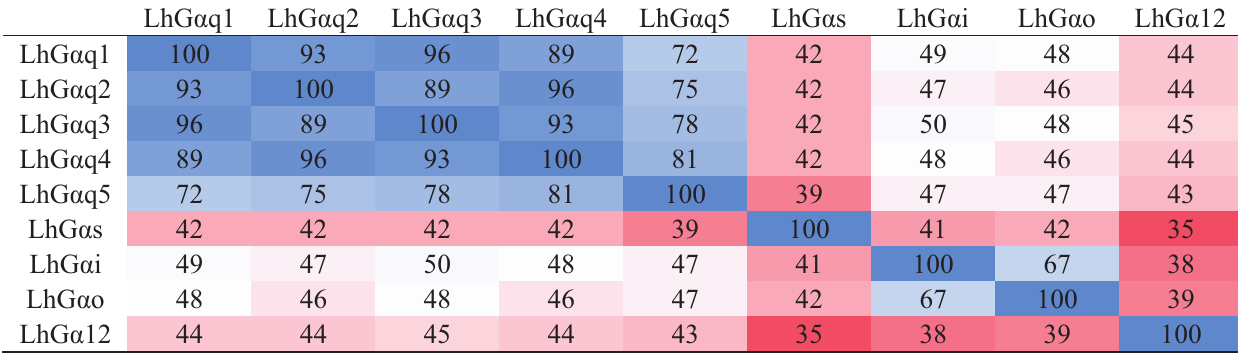
Figure 2. Alternative splice variants of LhG(cid:2)q. ( A ) MUSCLE-based sequence alignment of LhG(cid:2)q1-4; ( B ) MUSCLE-based sequence alignment of LhG(cid:2)q5 with LhG(cid:2)q1 and G(cid:2)q variants from A. gambiae (AAW50316; AgG(cid:2)q5) and Diaphorina citri (XP_008479779; DcG(cid:2)q1). The alignment corresponds to LhG(cid:2)q1 amino acid residues 187–353. Shading denotes amino acid sequence similarity and is scaled as: 100% similarity (black), 99%–80% (dark grey), 79%–60% (light grey), and less than 59% (white); ( C ) Proposed alternative splice scheme utilized to generate the cloned LhG(cid:2)q variants. Similar to A. gambiae and D. melanogaster , the LhG(cid:2)q locus appears to have three homologous exons (B/B', C/C', and D/D') that are alternatively spliced to generate the five LhG(cid:2)q variants. Putative exon-intron boundaries are based on observed sequence variations with coding sequences shown as boxes. Table 3. Percent identity matrix heat map for LhG(cid:2)